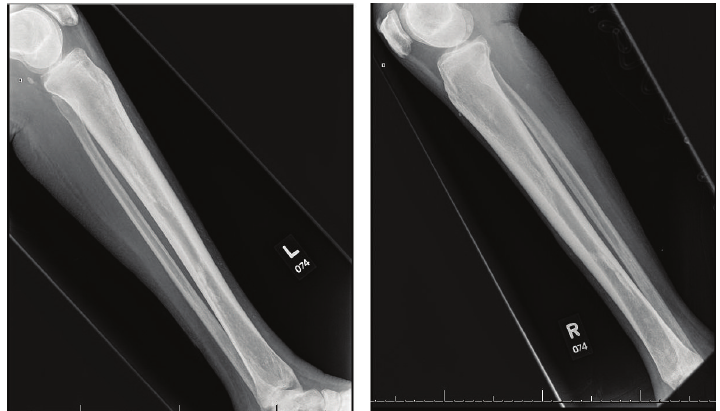
Figure 2: X-ray of both legs showing regions of sclerotic cortical thickening identified in the posterior distal metadiaphysis and anterior metadiaphysis of the tibia with additional sclerosis of the metadiaphyseal regions of the